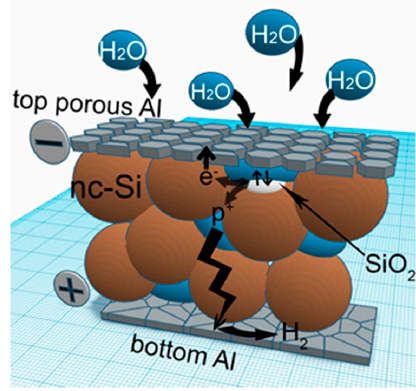
Figure 7. Scheme of the structure investigated, and imaging of potential difference formation.